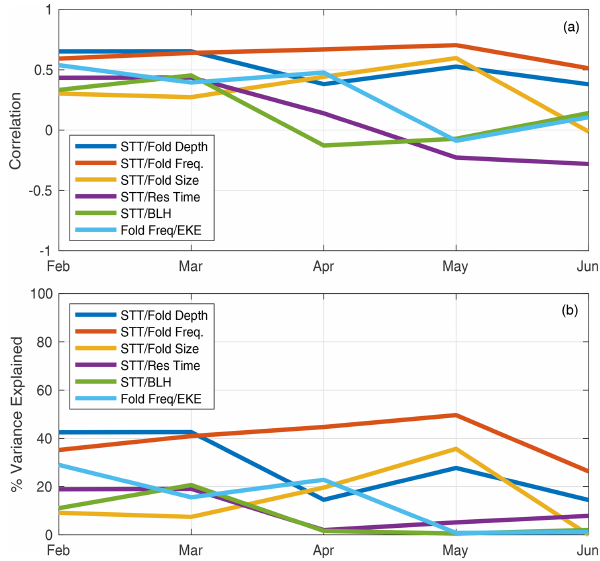
Figure 7. (a) Time series of the correlation ( r ) of monthly mean STT-PBL with various tropopause fold characteristics, residence time of PC1 ± 5, mean PBL height, and mean EKE. Panel (b) shows the corresponding percent variance ( r 2 ) explained by each relation-